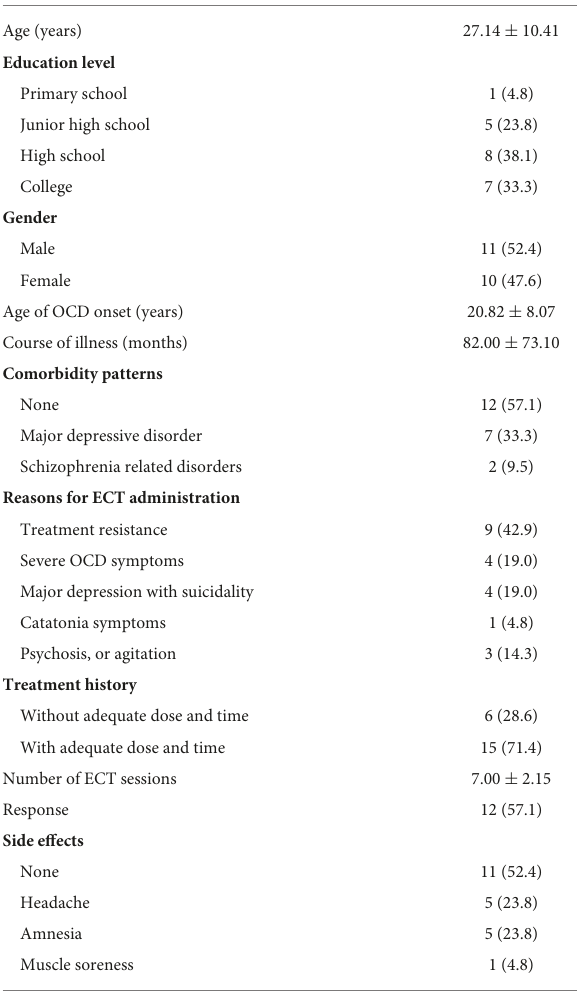
TABLE 1 Clinical and demographic